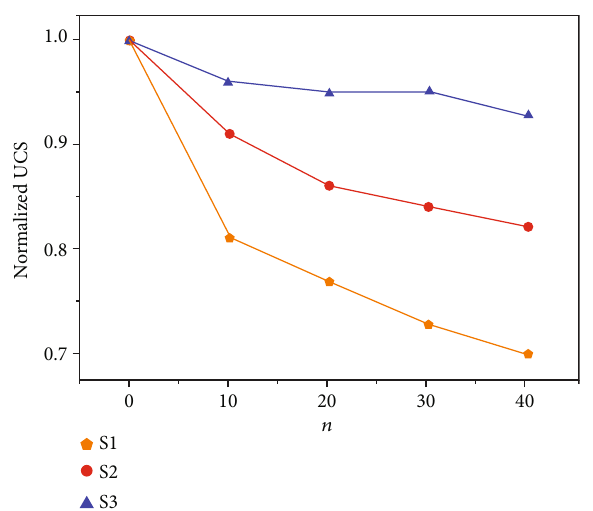
Figure 5: Normalized UCS of tested sandstones versus the number of WD